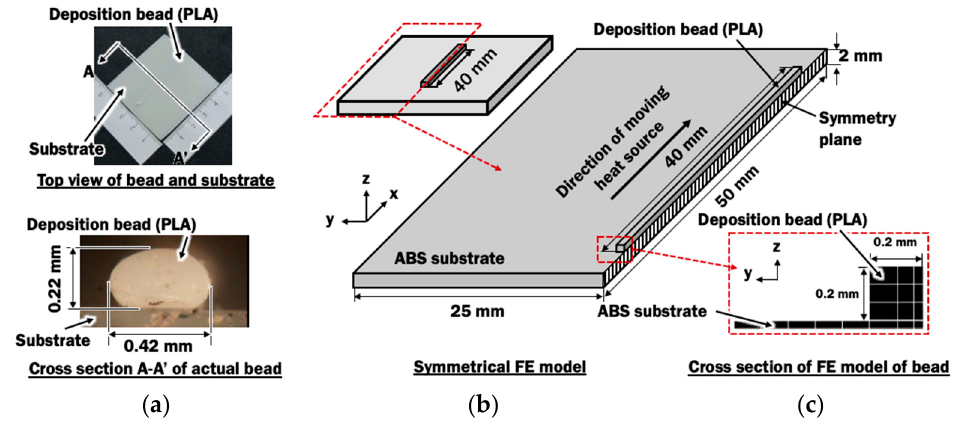
Figure 6. ( a ) Dimension of actual bead; ( b ) A symmetrical finite element model for deposition process. ( c ) Cross section of FE model of bead. Table 2. Parameters for finite element model during deposition process.